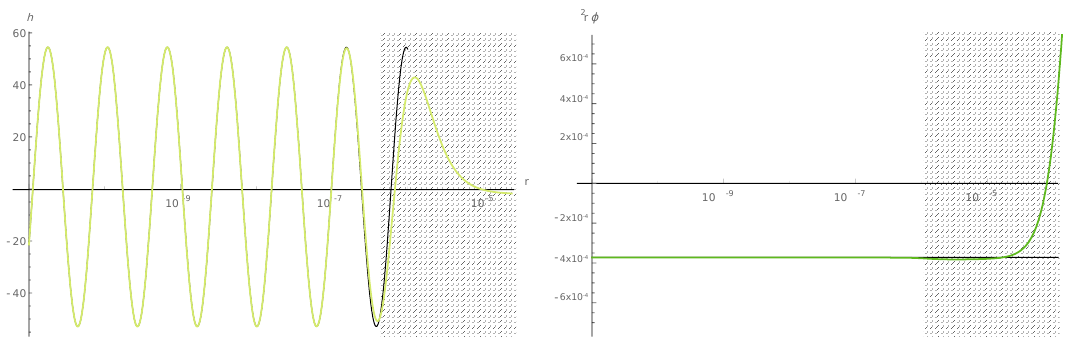
Figure 7 . Radial profiles for h (left) and r 2 φ (right) on the gauge oscillations epoch. The colored curves correspond to the full non linear evolution while the black ones to the small r approximation. The values of the parameters correspond to the black hole shown in figure 1